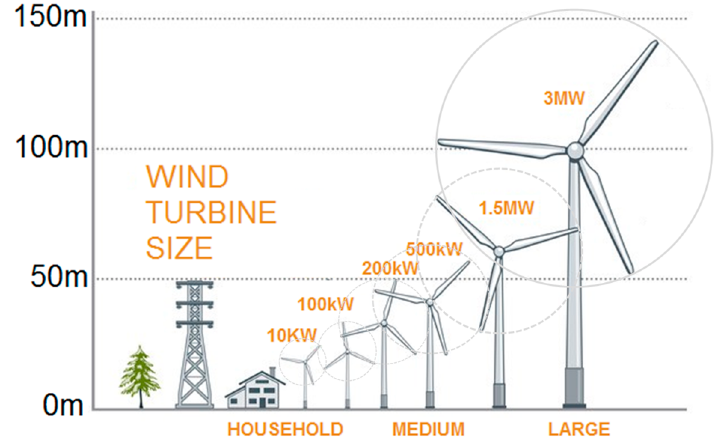
Figure 1. Different sizes and capacity of wind turbines.